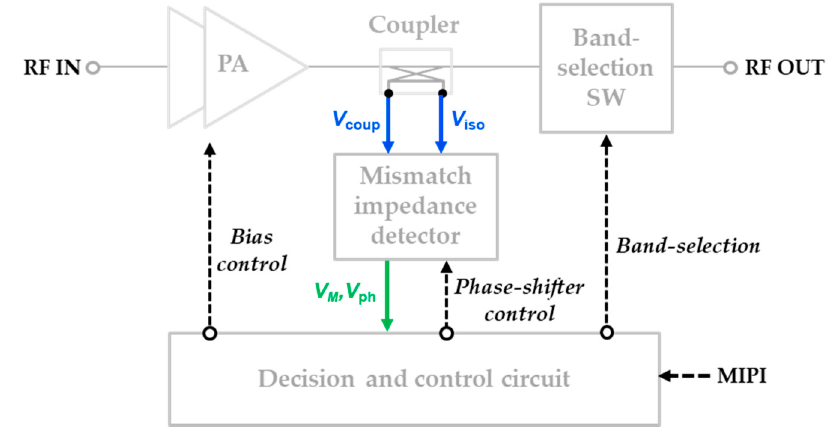
Figure 3. Configuration of proposed closed-loop protection method.